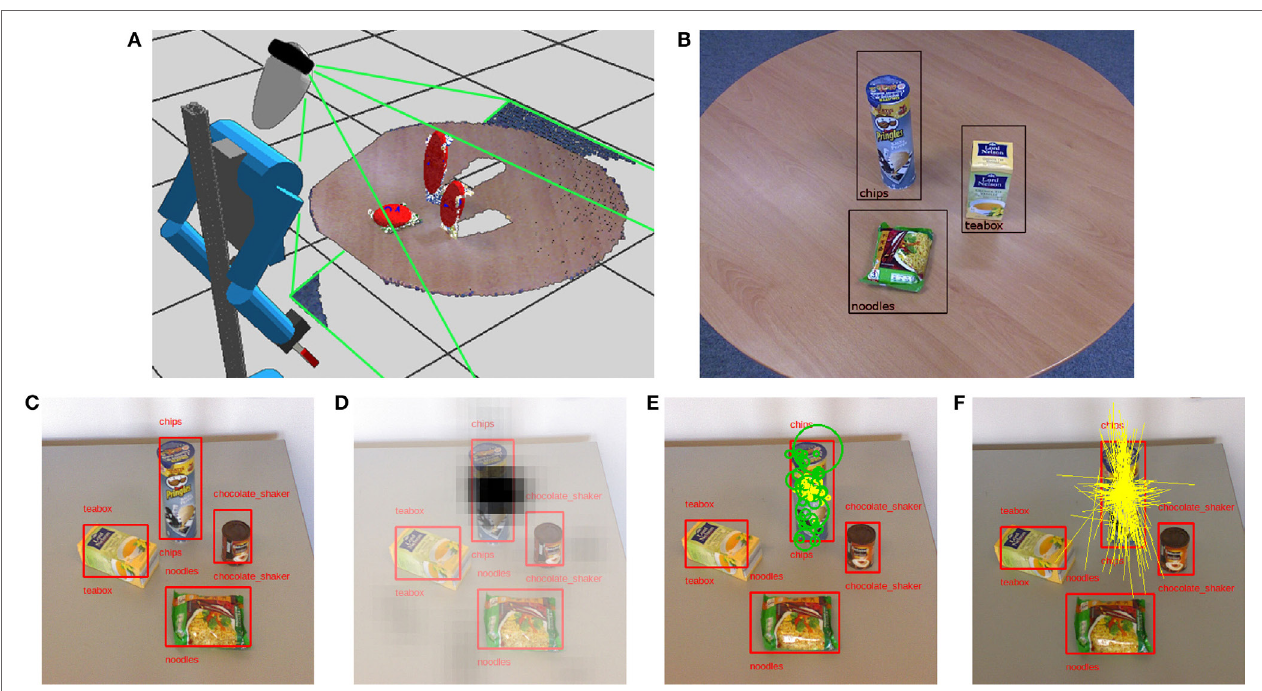
FIgURe 6 | object perception (Stückler et al., 2013a) . (A) Cosero capturing a tabletop scene with its RGB-D camera. The visible volume is indicated by the green lines. Three objects are detected on the table. Each object is represented by an ellipse fitted to its points, indicated in red. (B) RGB image of the tabletop with recognized objects. (c) We recognize objects in RGB images and find location and size estimates. (D) Matched features vote for position in a 2D Hough space. (e) From the features (green dots) that consistently vote at a 2D location, we find a robust average of relative locations (yellow dots). (F) We also estimate principal directions (yellow